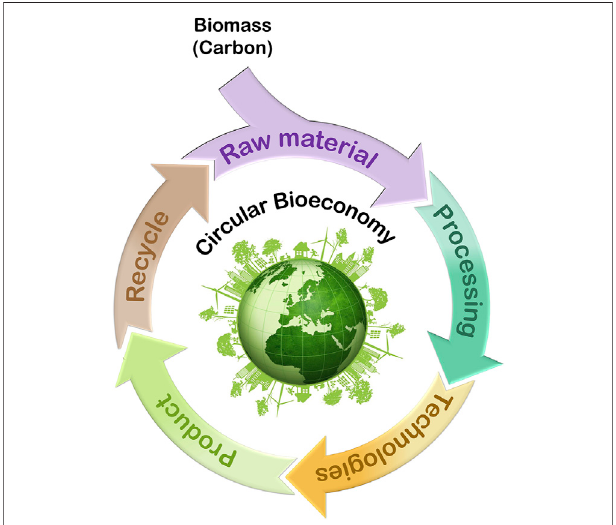
FIGURE 1 | Use of biomass within the circular bioeconomy